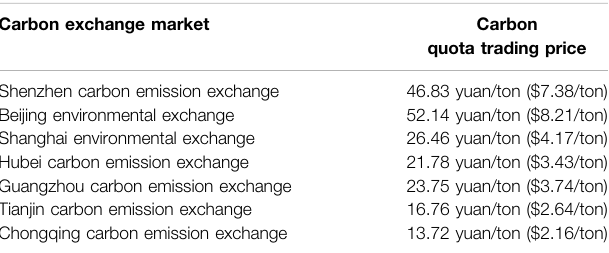
TABLE 3 | Average price of carbon trading in the primary market from 2013.06 to